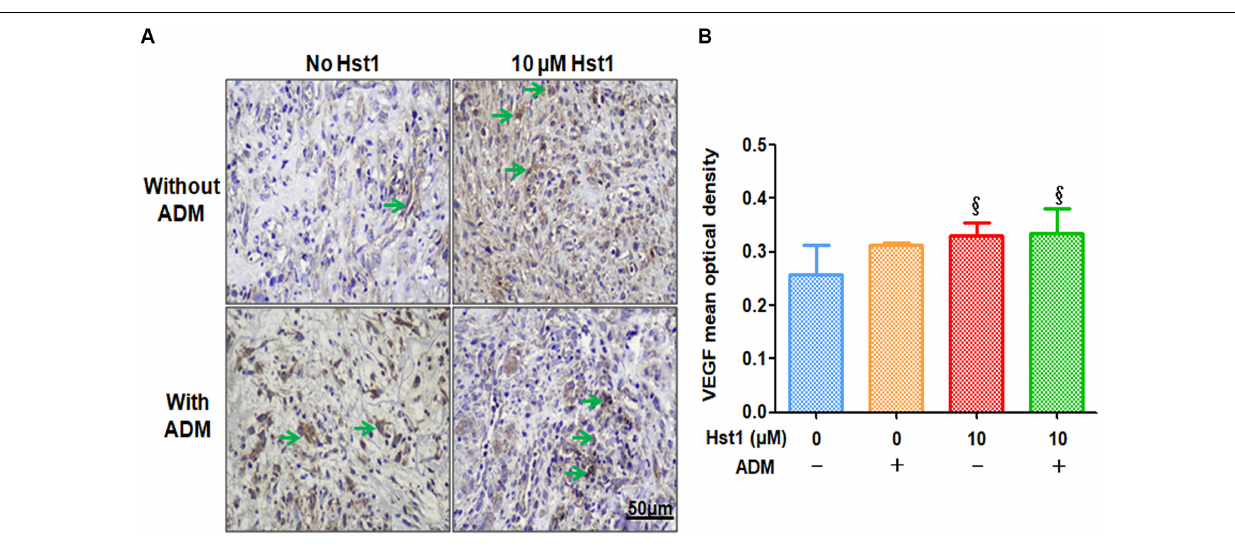
FIGURE 5 | Immunohistochemical evaluation of angiogenic marker VEGF positive expression. (A) 14 days post-surgery, the positive expression level of VEGF (in green arrows) in the 10 µ M Hst1 group was higher. The scale bar = 50 µ m. (B) Quantitative analysis of the VEGF expression level at wound sites. 14 days post-surgery, the VEGF expression in the groups of 10 µ M Hst1 and ADM + 10 µ M Hst1 was significantly higher compared with the control group and ADM group. §: The 10 µ M Hst1 group and 10 µ M Hst1 + ADM group vs the control group ( P <